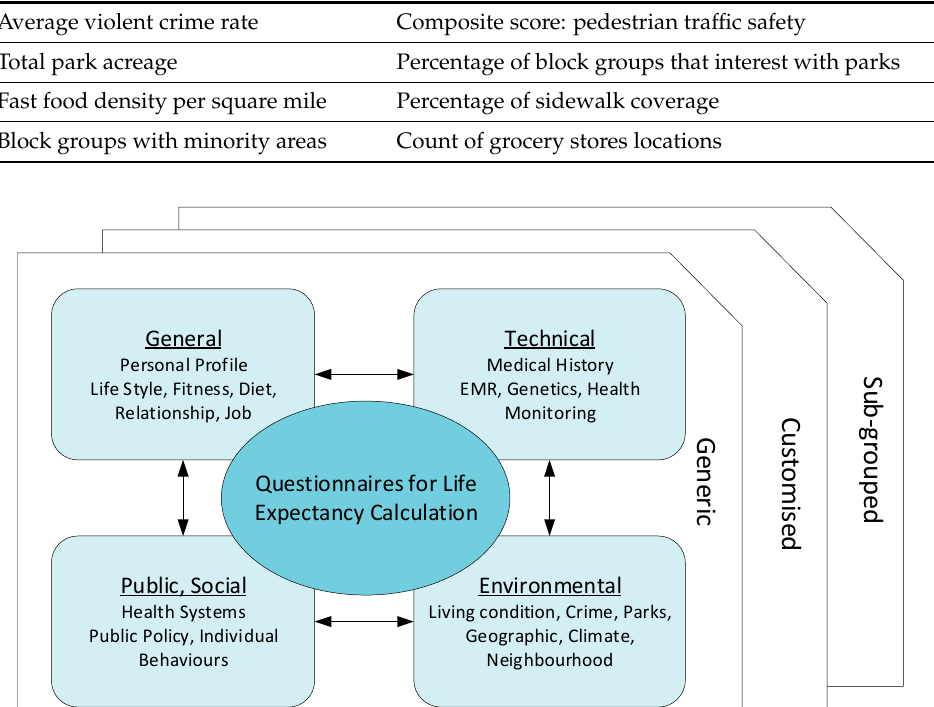
Figure 6. Information flow of health data creation. Initial data are entered by users using their smartphone apps, and optimized data from the cloud server are sent back to the app for fine-tuned prediction.